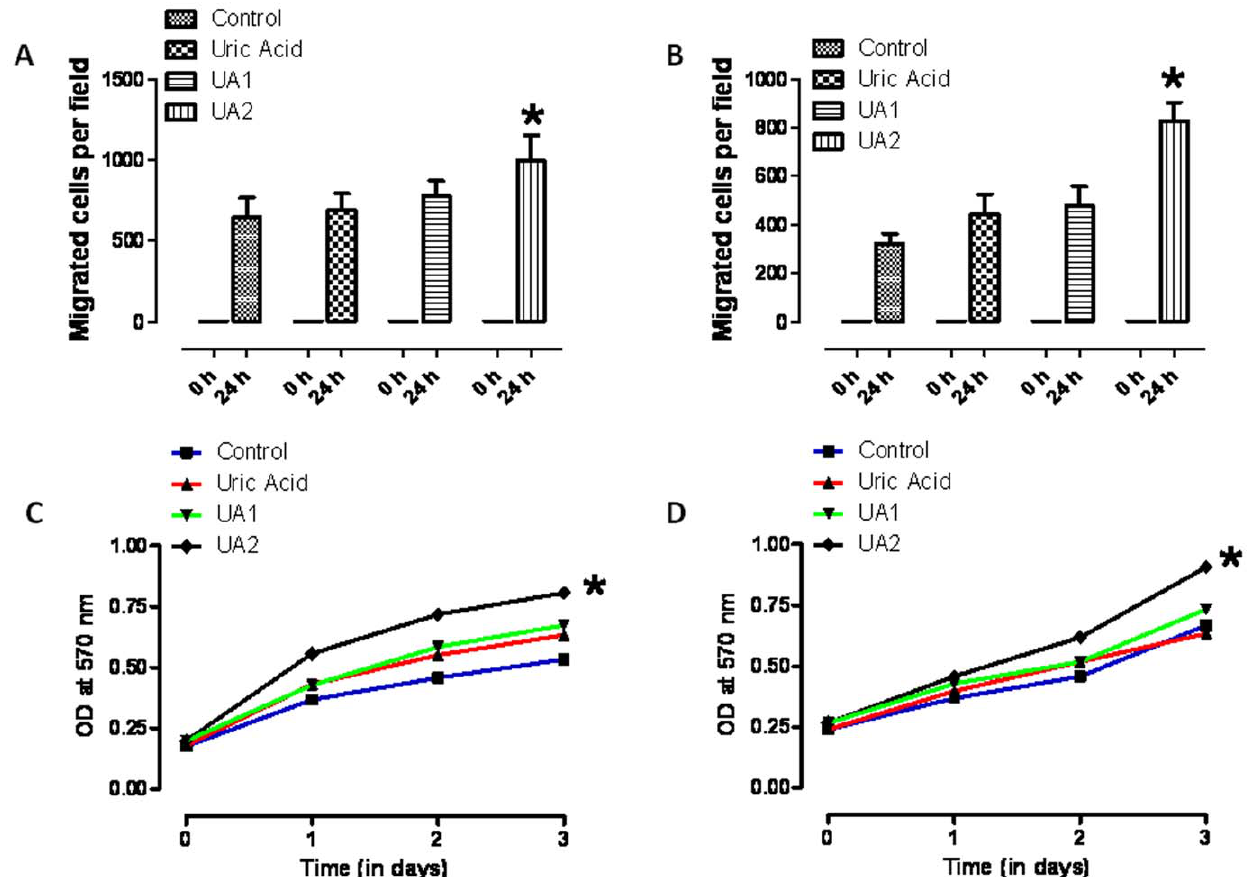
Figure 2. A uric acid analog enhances the motility and proliferation of keratinocytes and fibroblasts. A–D. Monolayers of cultured keratinocytes (A) or fibroblasts (B) were treated with vehicle (Control), UA, UA1 or UA2 (15 m M) and were then subjected to scratch wounding. Eighteen hours after wounding, images of the wound area were acquired and the number of cells per field that had migrated into the cell-free wound zone was determined for each culture. Quantitative data A&B are shown. Values are the mean and SEM (n=3 separate experiments). *p,0.05. C and D. Cultured keratinocytes (C) and fibroblasts (D) were treated with vehicle (Control), UA, UA1 or UA2 (15 m M) for the indicated time periods and relative cell numbers were estimated by O.D readings, p , 0.01. Values are the mean and SEM (n=4–6 experiments).